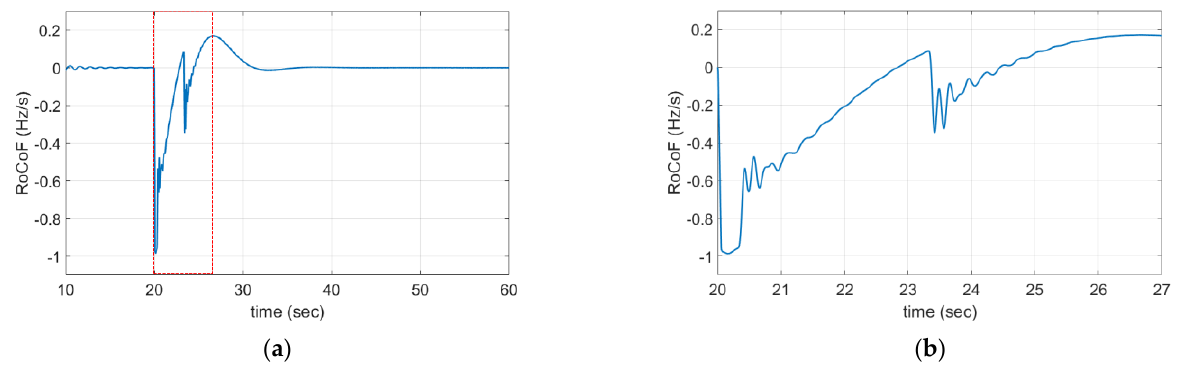
Figure 10. FFR with only the PMSG control: ( a ) the RoCoF; ( b ) the RoCoF (enlarged view).